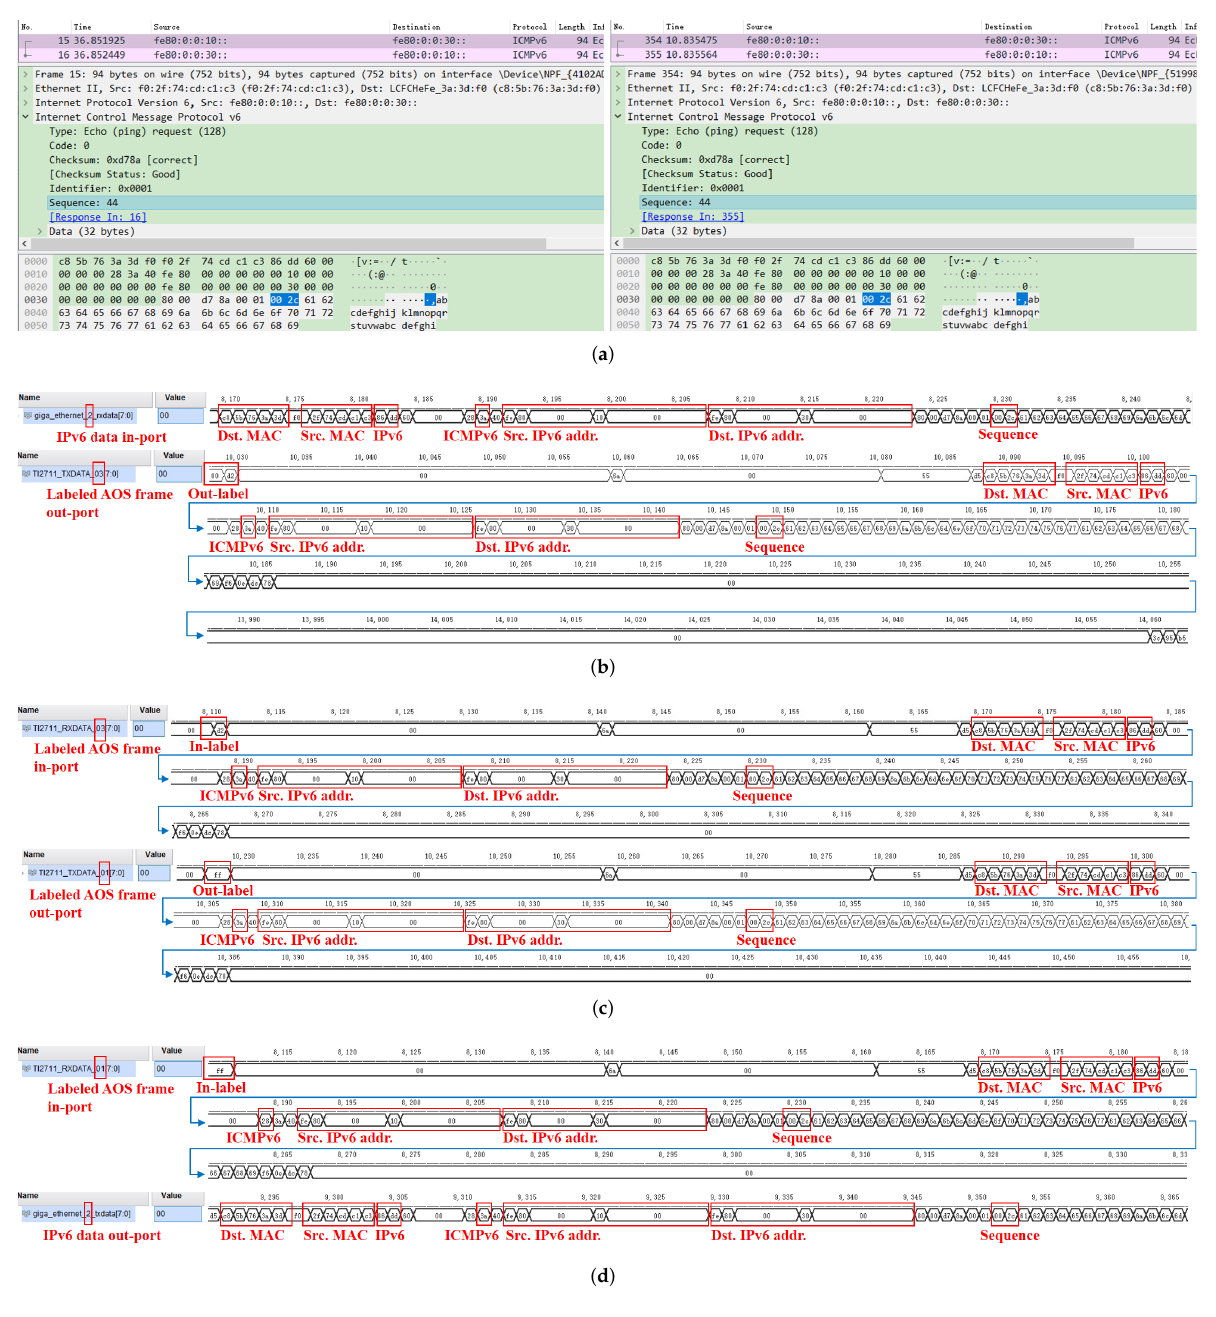
Figure 22. The label-based AOS frame switching in forward label switching path under the cir- cumstances of bi-directional link between node vx_simulator_01 (ingress LER, SCID 1), node vx_simulator_02 (LSR, SCID 2) and node vx_simulator_03 (egress LER, SCID 3) in the semi- physical platform. ( a ) The IPv6 data transmitted from node vx_simulator_01 (SCID 1) to node vx_simulator_03 (SCID 3). ( b ) The forward-FIB-based label pushing of AOS frame in node vx_simulator_01 (SCID 1). ( c ) The forward-LFIB-based label swapping of AOS frame in node vx_simulator_02 (SCID 2). ( d ) The forward-FIB-based label popping of AOS frame in node vx_simulator_03 (SCID